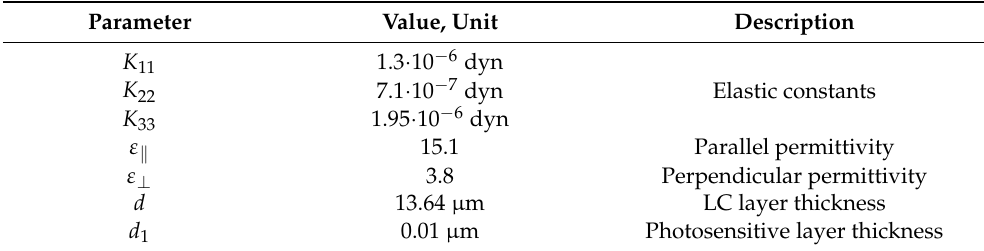
Table 1. Material parameters describing the ORW e-paper.